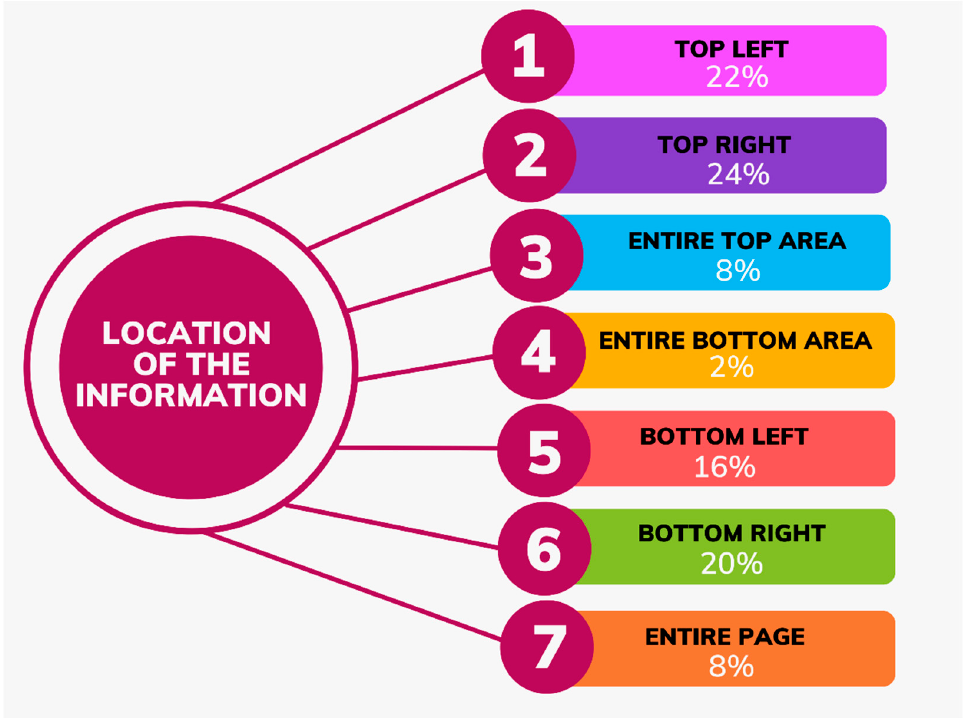
Figure 6. Location of the information about COVID-19.